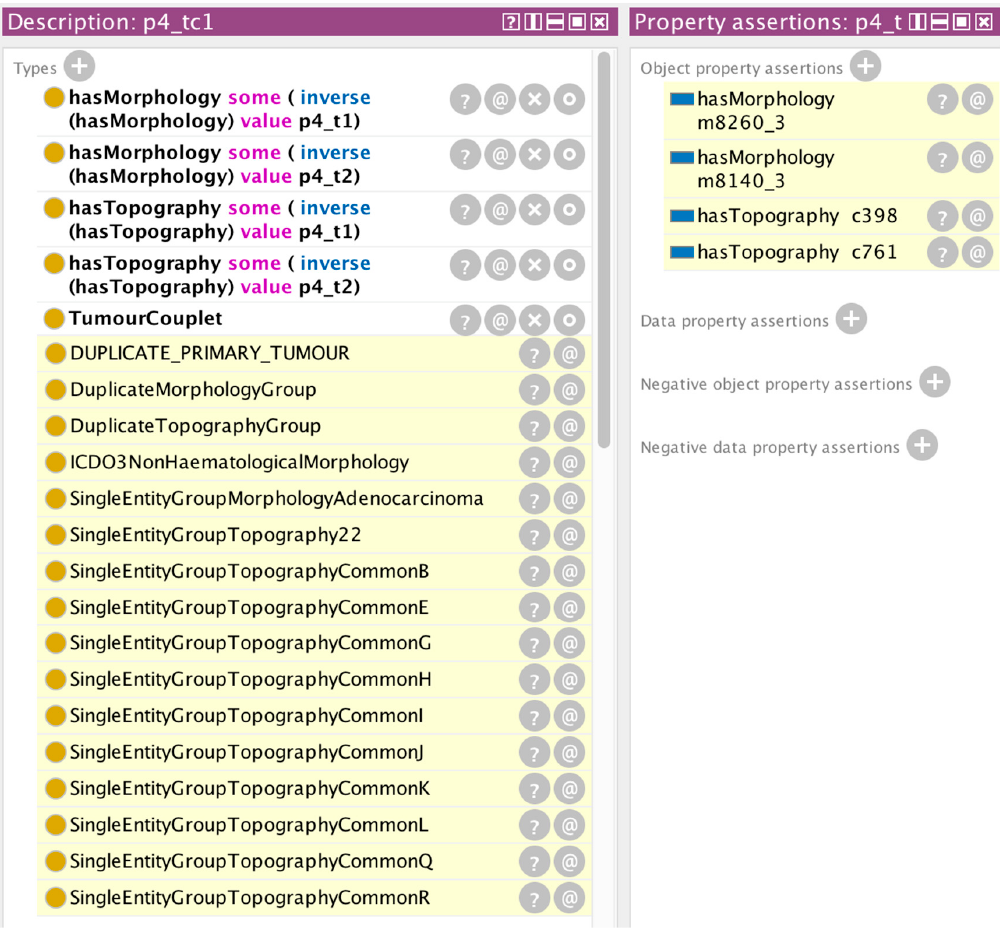
Figure 9. Results of the reasoning operation for the tumour couplet p4_tc1. Both topography codes and the non- haematological morphology codes are equivalent and the couplet is an invalid MPT.